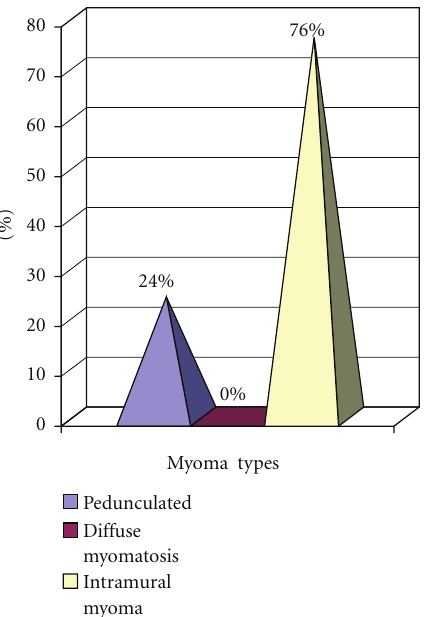
Figure 2: Types of myomas according to their type of surgery lap- aroscopic myomectomy ( n = 178).